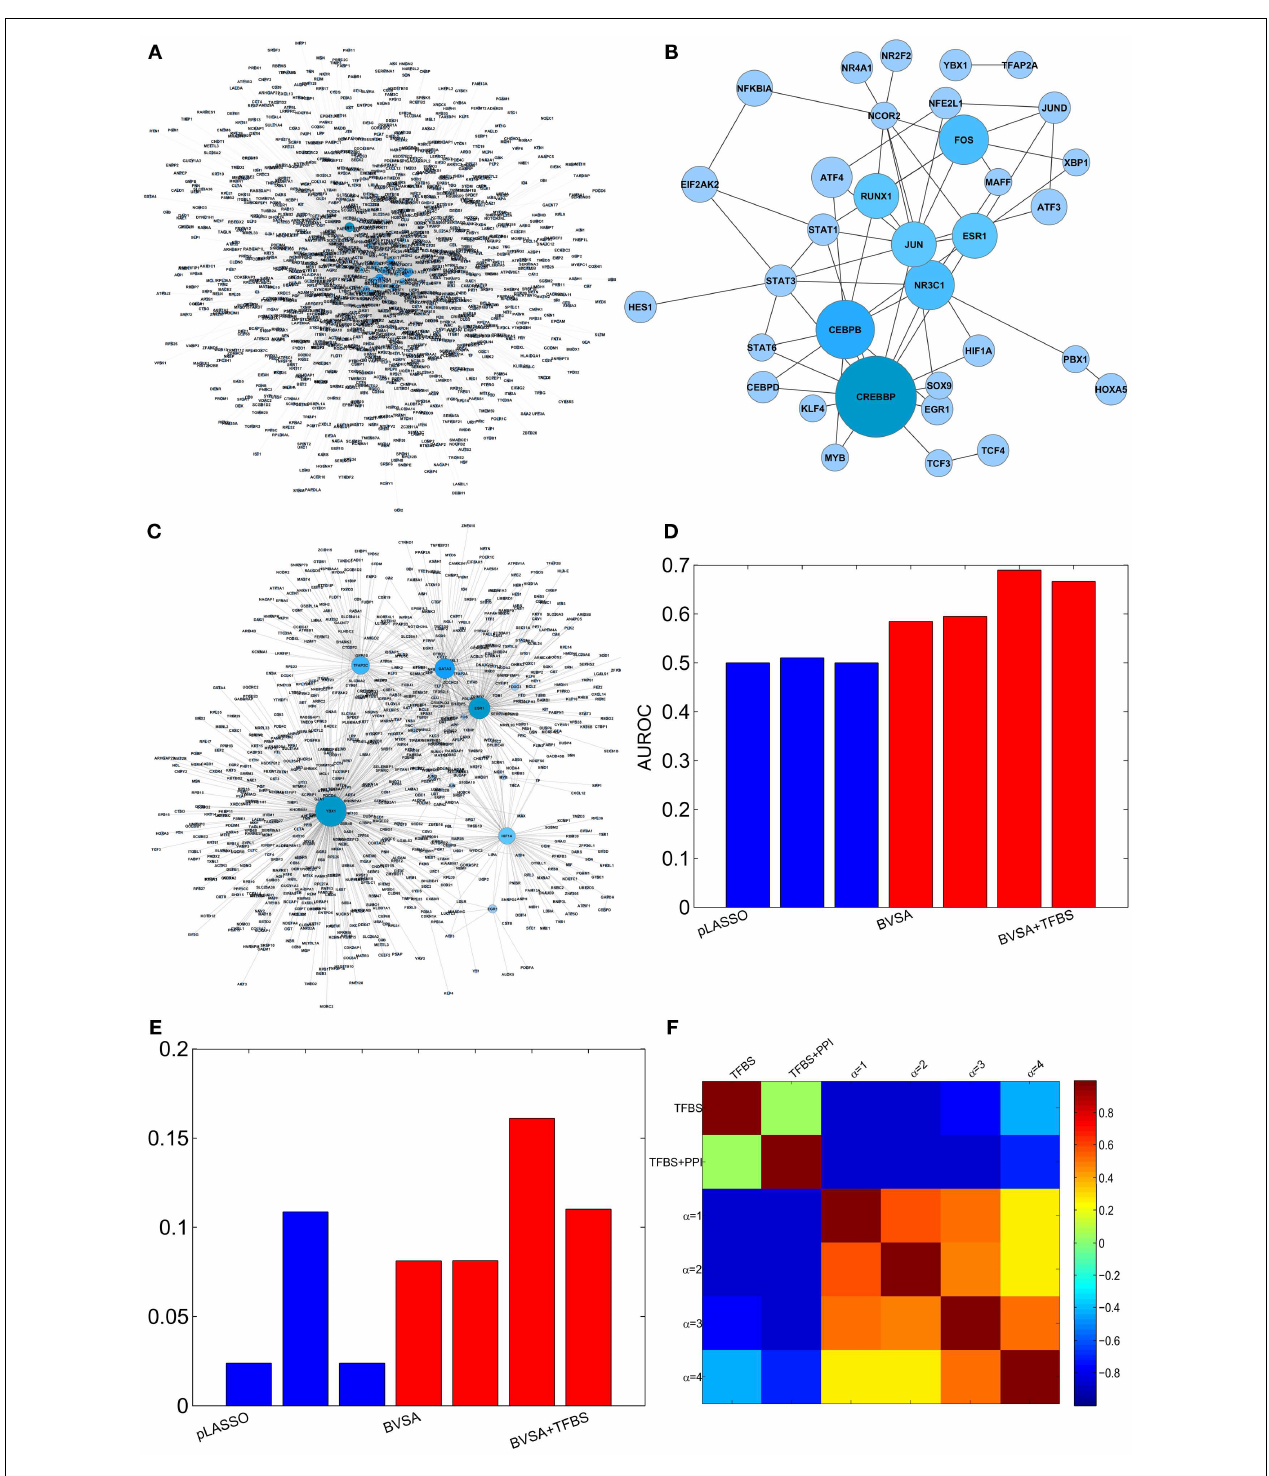
algorithm to the confidence parameter ( α c ). Here,TFBS represents the prior network constructed fromTFBS data,TFBS + PPI represents the prior network constructed from bothTFBS and PPI information, α = 1, 2, 3, 4 represents the networks inferred from Γ TFBS + PPI with confidence parameters α = 1, 2, 3, 4, c